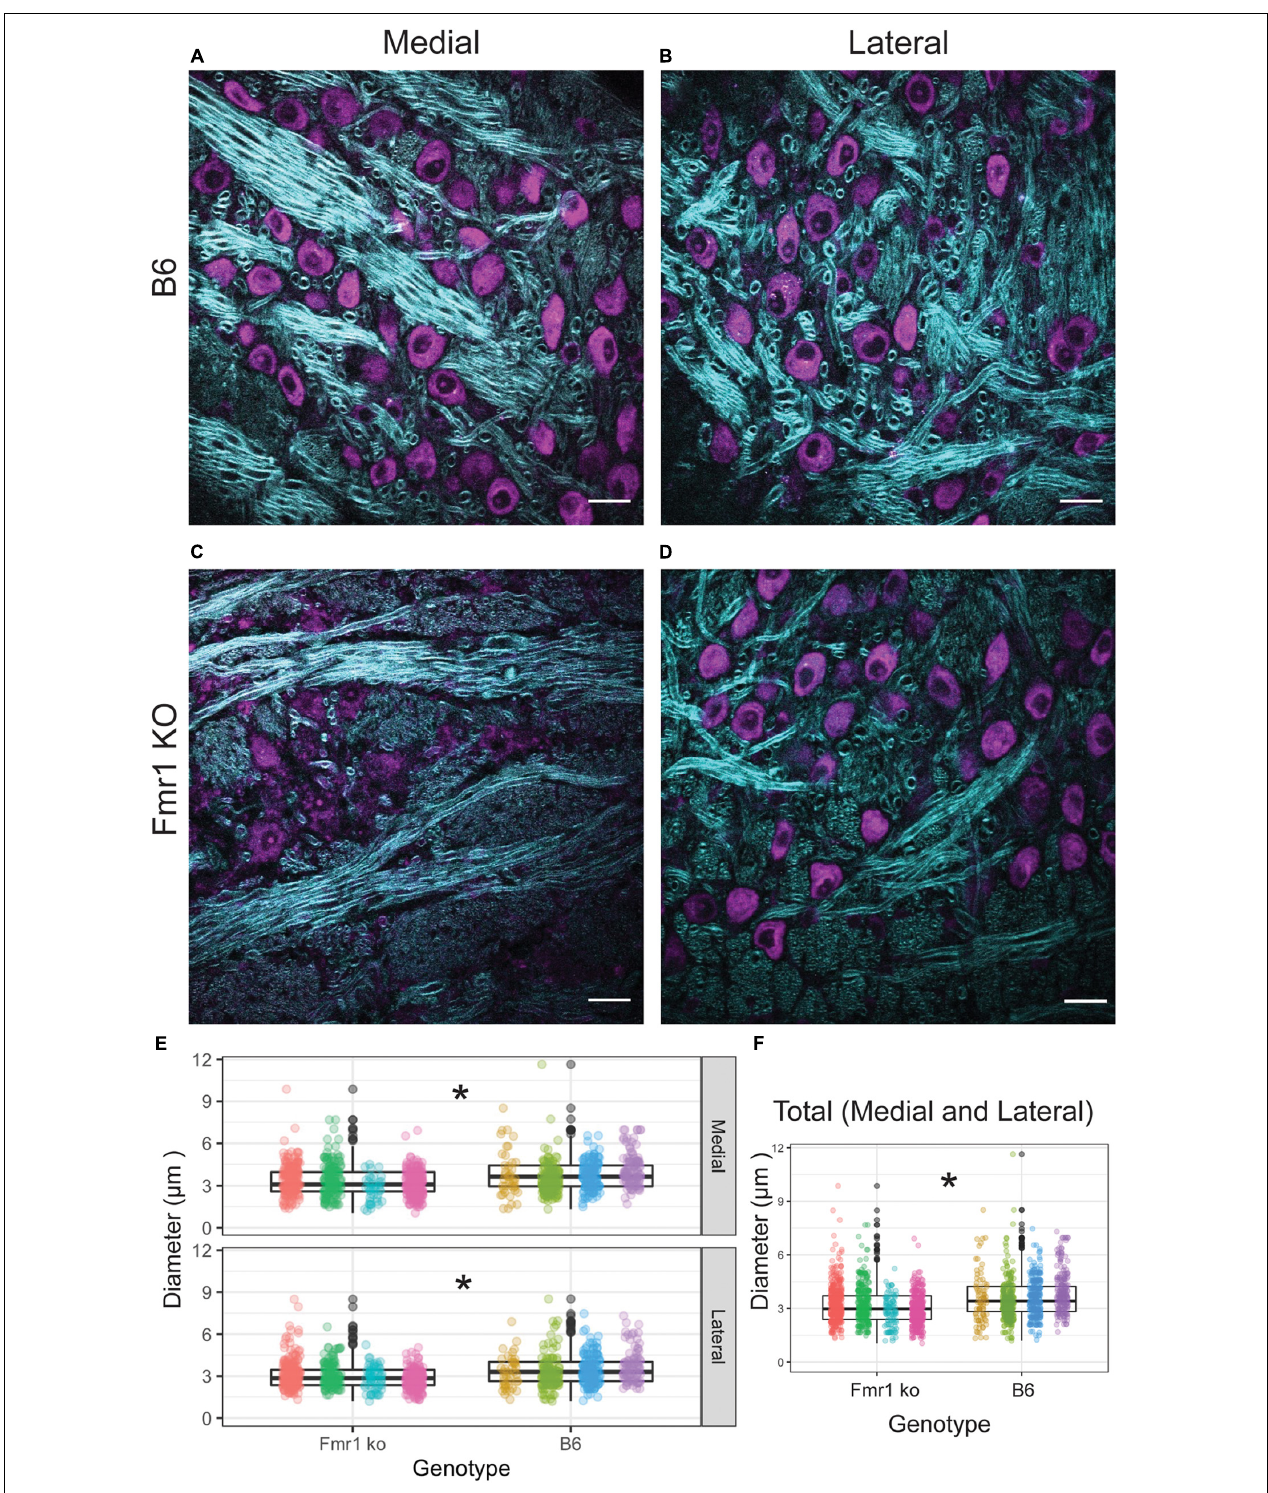
FIGURE 3 | Fiber diameter size is reduced in Fmr1 KO mice compared to B6 using CARS. Representative images for medial and lateral (columns) MNTB in B6 and Fmr1 KO mice (rows) (purple indicates cell bodies stained with Nissl, CARS signal in cyan) (A–D) . Scale bar is 20 µ m. Box plots show data from each individual animal (color spread) and population data represented by the box for Fmr1 KO (left) and B6 (right) for either medial (top) or lateral (bottom) MNTB (E) . N for each genotype was four animals with 20 measurements per section and 4–6 sections per animal. Panel (F) shows the data independent of medial or lateral location (total) for each animal across genotype. * p <